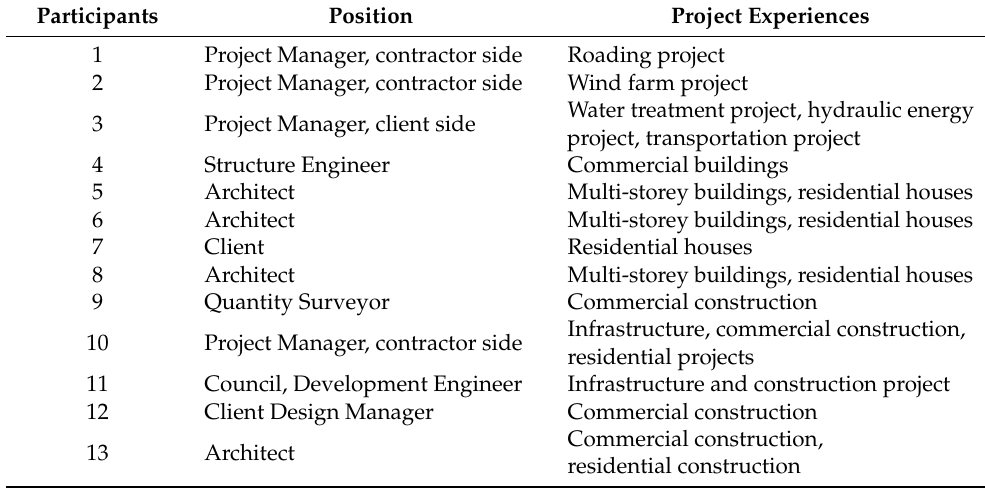
Table 2. Participant